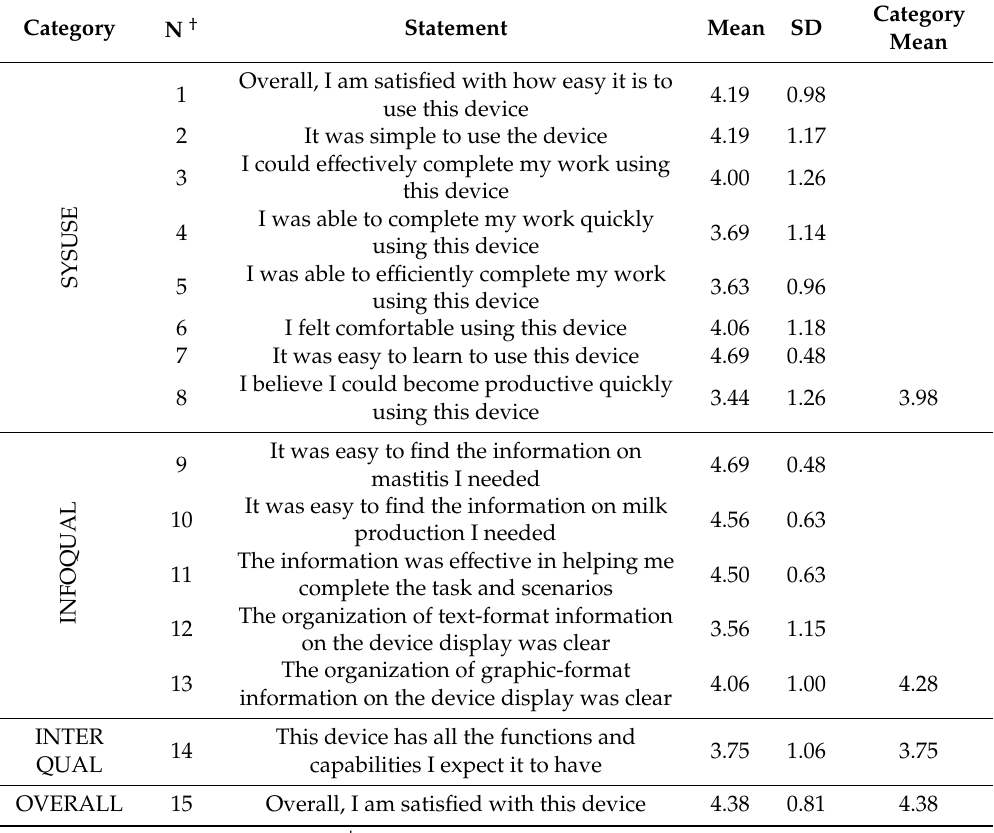
Table 3. Mean score for each statement of the modified IBM Computer System Usability Questionnaire (CSUQ). The four categories are reported: System usefulness (SYSUSE), Information quality (INFOQUAL), Interface quality (ITERQUAL), Overall satisfaction